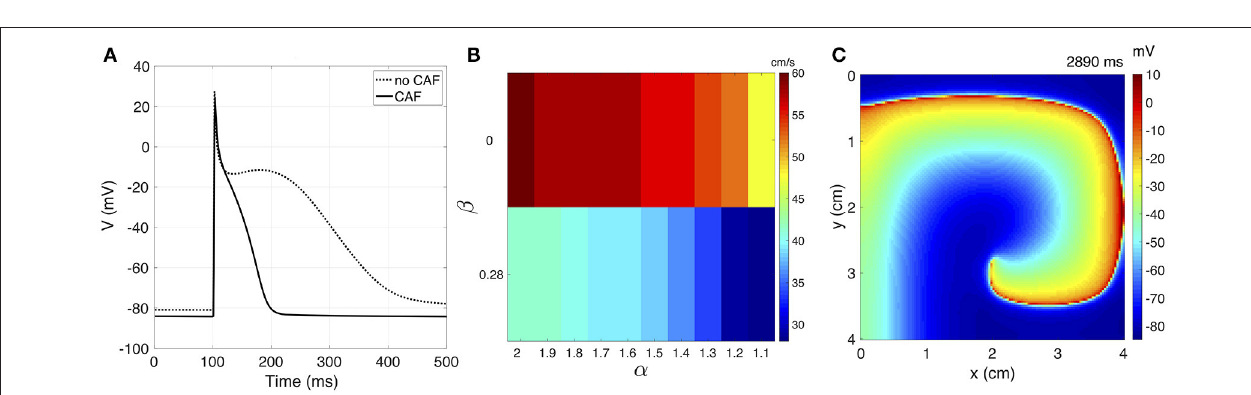
by 5%, while for γ = 2 + j 0 and γ = 1.2 + j 0.28 the CV